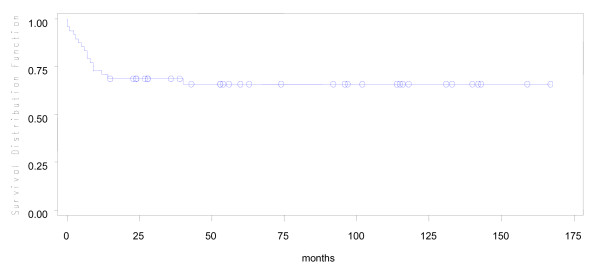
Disease-free survival in young patients with colorectal cancer.